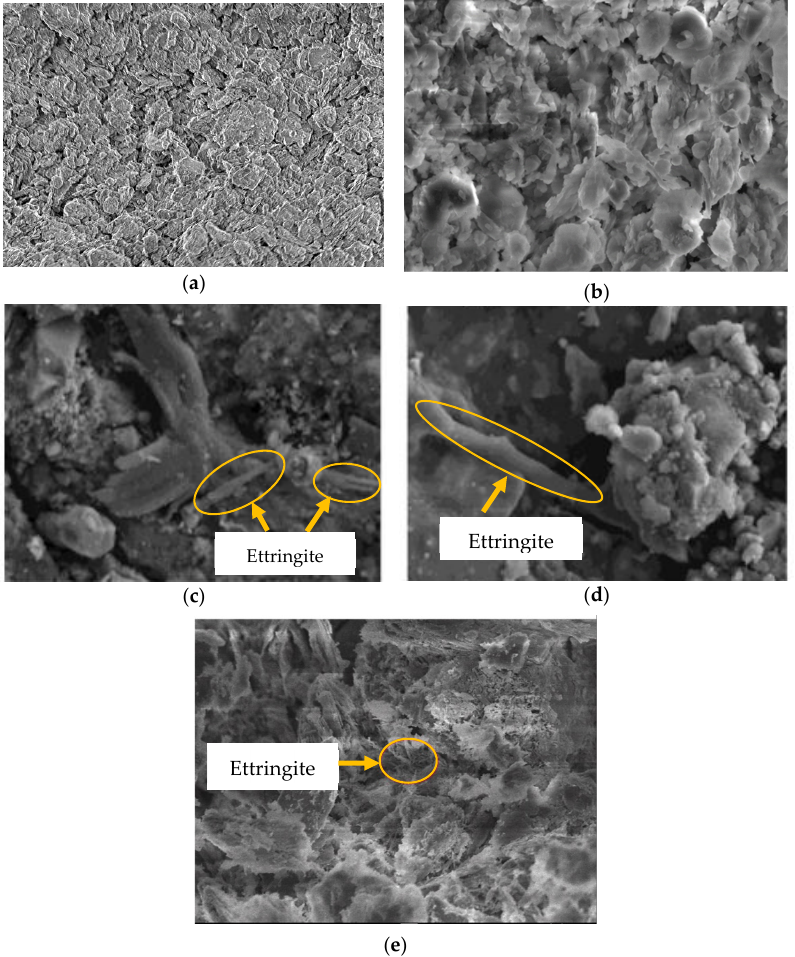
Figure 8. Scanning electron micrograph: ( a ) Pure soil (kaolinite); ( b ) sulphate soil; ( c ) lime-stabilised sulphate soil [36]; ( d ) lime-stabilised sulphate soil [36] ( e ) lime/GGBS-stabilised sulphate soil [15].